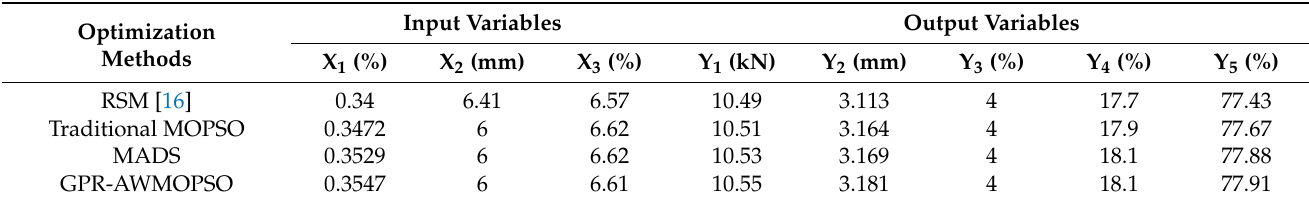
Table 5. Comparison of optimization results among RSM [16], traditional multi-objective particle swarm optimization (MOPSO), mesh-adaptive direct search (MADS) and GPR-adaptive weight multi-objective particle swarm optimization (AWMOPSO)